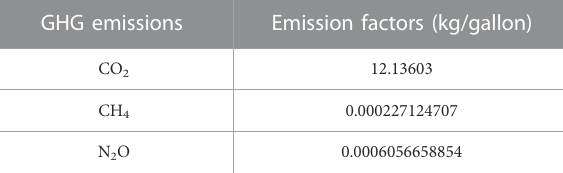
TABLE 5 GHG emission factors (EFs) for marine gas oil (MGO).